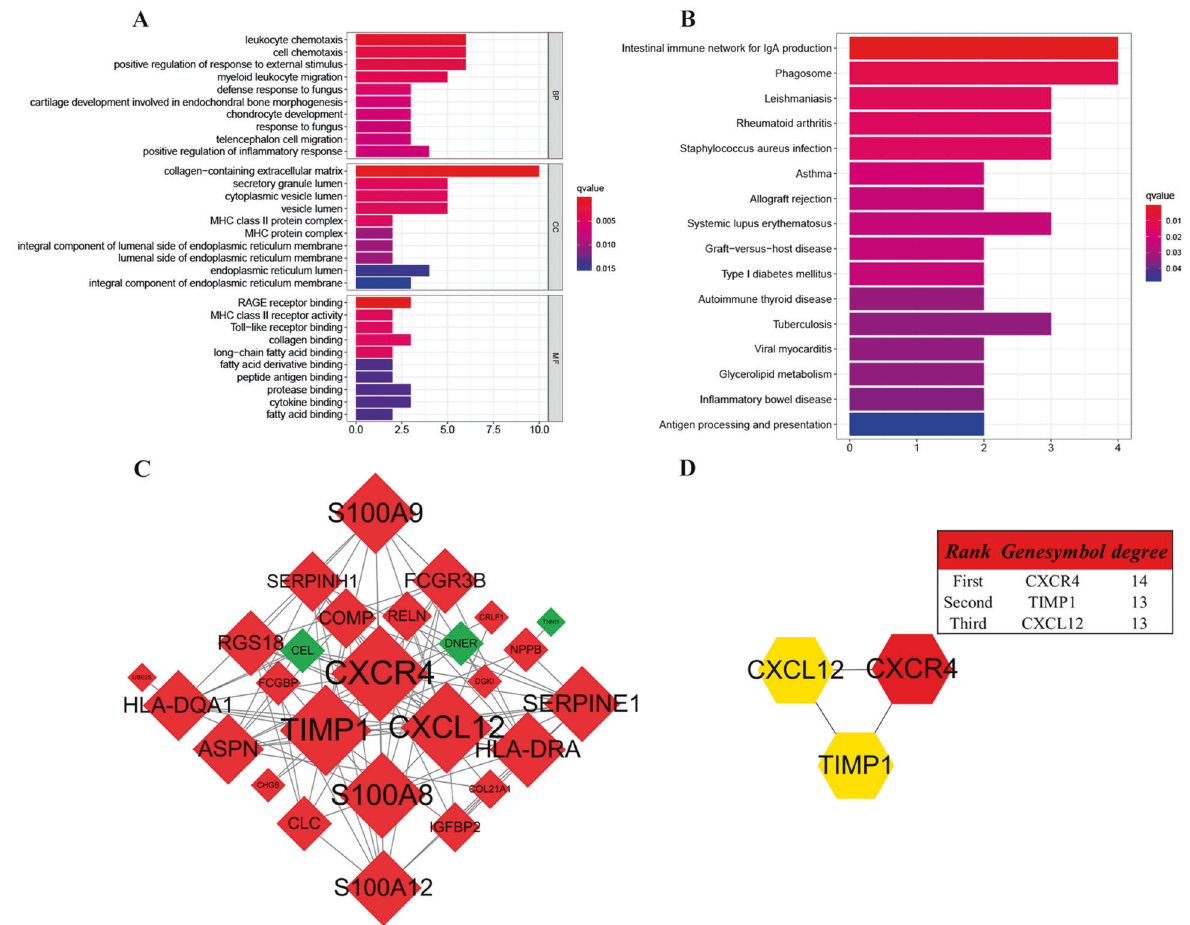
Fig. 2 The DEGs ’ GO and KEGG functional enrichment and PPI network. A GO functional enrichment of DEGs, which includes BP, CC, and MF. B KEGG pathway enrichment of DEGs. GO terms and KEGG pathways are presented in the bar chart. The y- axis depicts names of GO terms and KEGG pathways, and the x -axis depicts the count of genes in each GO term or KEGG pathway. The higher q value is shown in color blue, while the lower value is shown in red. C PPI network of DEGs. The nodes represent proteins, the edges represent the interaction of proteins. The green and red diamonds indicate downregulated and upregulated DEGs in AF group respectively. The size of the diamond is positively correlated with nodes ’ degree calculated by Cytohubba in the network. The larger the diamond, the higher the degree of the protein represented by the node in the network. D The top three hub genes screened by degree in PPI network. Red, greater degree. Yellow, lesser degree. GO Gene Ontology, KEGG Kyoto Encyclopedia of Genes and Genomes, DEG differentially expressed gene, BP biological process, MF molecular function, CC cellular component, PPI protein – protein